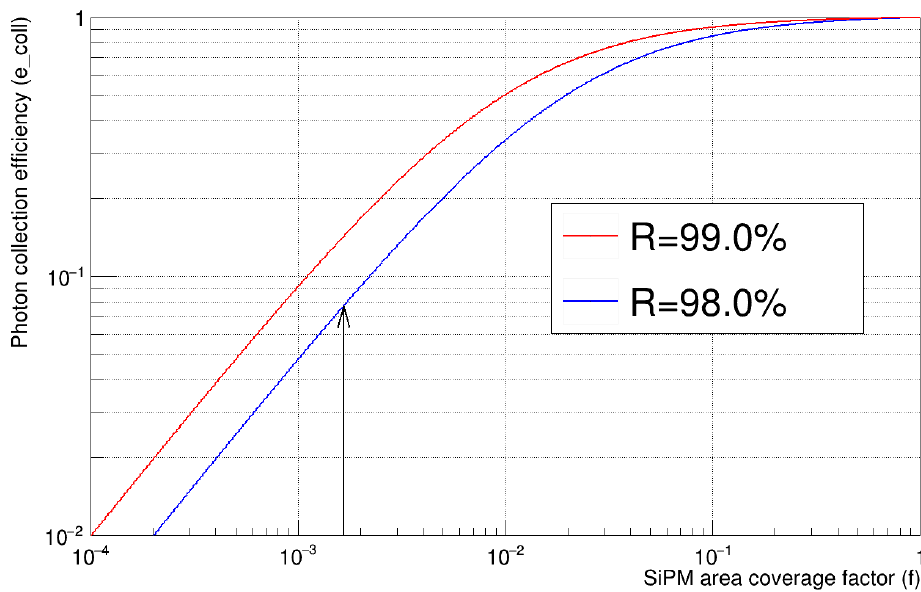
Figure 7. Collection efficiency as a function of the silicon photomultipliers (SiPM) area coverage fraction f. The 98% reflection coefficient is that used in the prototype [15], 99% shows a potential improvement. The arrow indicates the value of the SiPM coverage for the